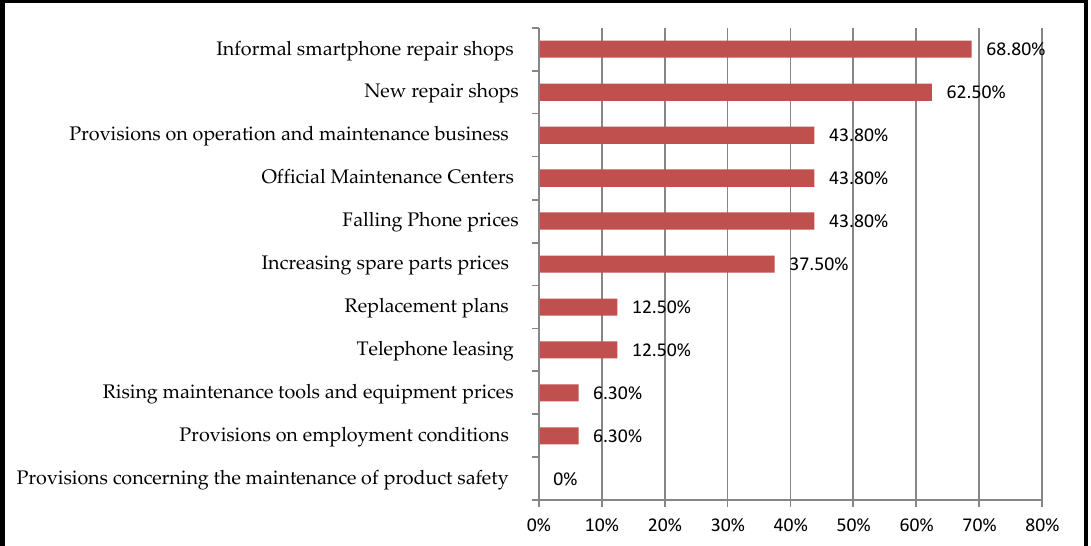
Figure 5. Business threats to mobile phone repair shops in the Netherlands .